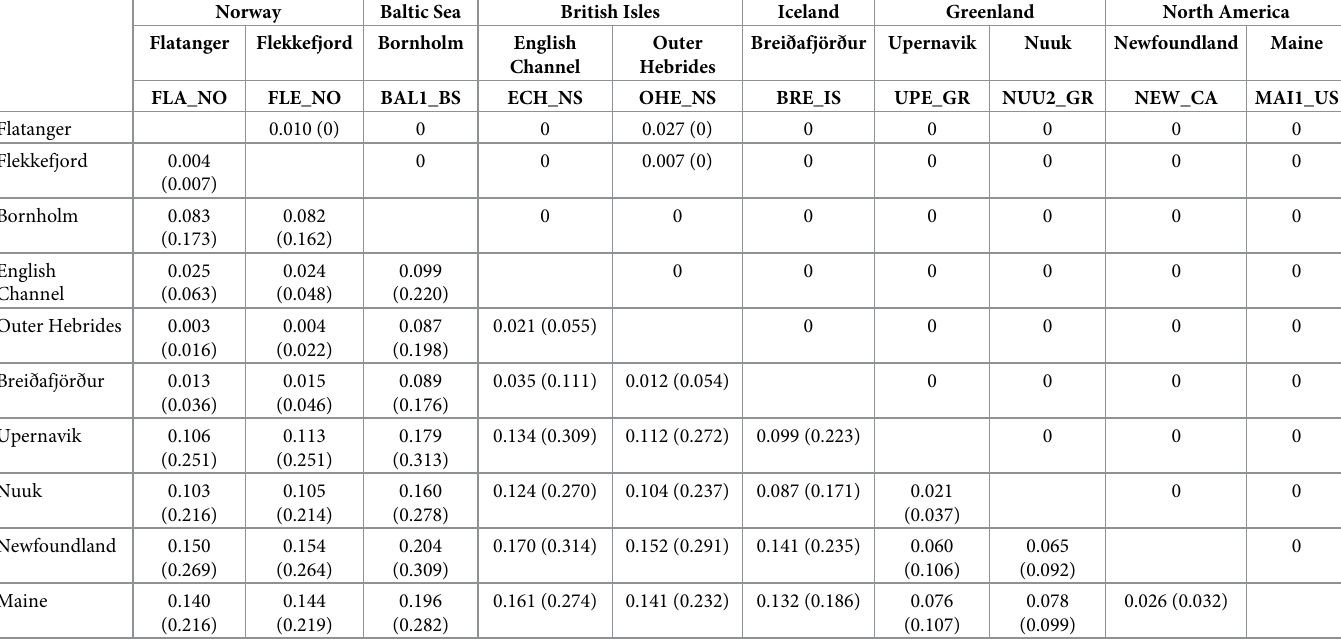
Table 2. Pairwise F ST values among samples of lumpfish ( Cyclopterus lumpus ) with both genome-wide and targeted SNPs. Below diagonal shows estimated F ST s. The first value is from the genome-wide data (4,393 SNPs) and in parentheses from the targeted data (139 SNPs). Above diagonal shows corresponding p values based on 2,000 bootstraps. If only one value is given, both comparisons coincided with that value. Pairwise F ST table including remaining samples from the targeted SNP data is given in Table A in S4 Table.